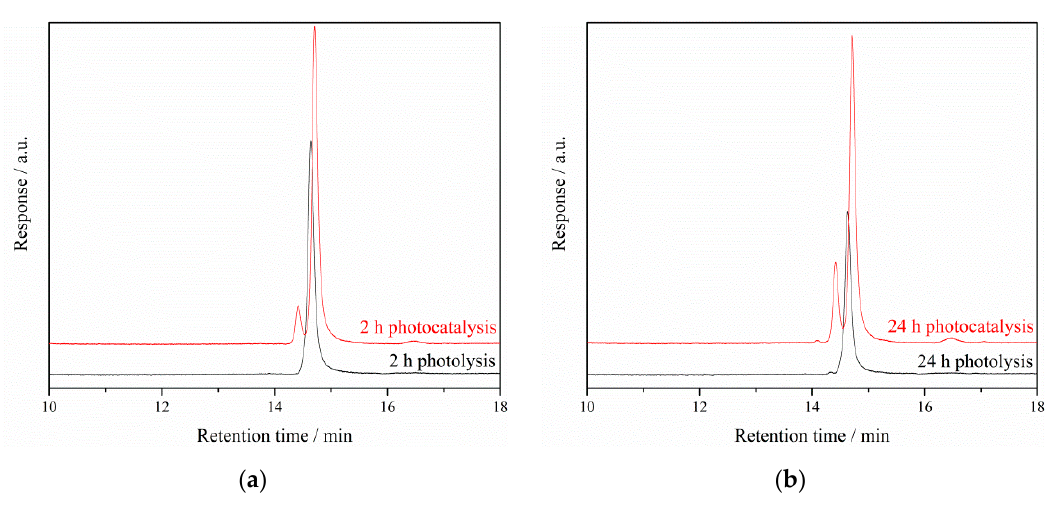
Figure 6. Chromatograms of SFX samples under both photocatalytic and photolytic conditions upon irradiation with visible light after: ( a ) 2 h and ( b ) 24 h.